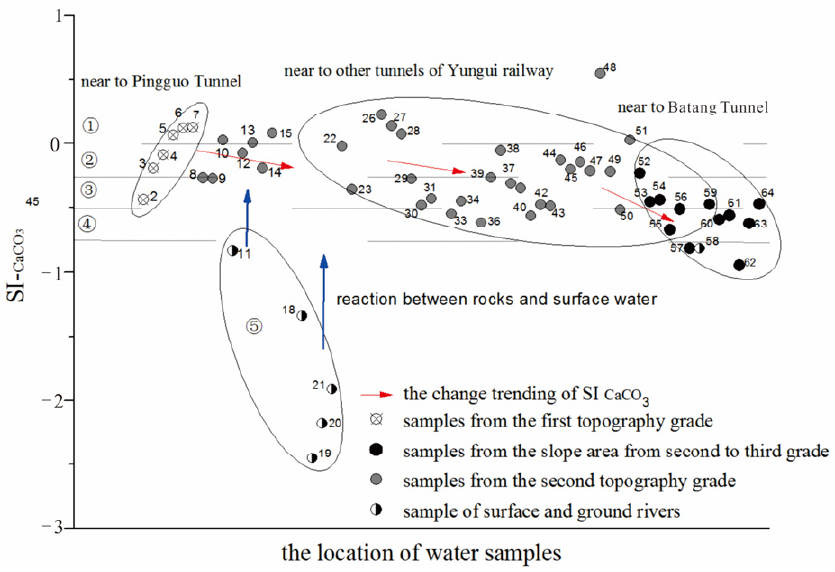
Figure 7. SI- CaCO3 of calcium carbonate in samples. 1 (cid:13) SI ranges from 0 to 0.25; 2 (cid:13) SI ranges from Figure 7. SI- CaCO of calcium carbonate in samples. ① SI ranges from 0 to 0.25; ② SI ranges from 3 − 0.25 to 0; 3 (cid:13) SI ranges from − 0.5 to − 0.25; 4 (cid:13) SI ranges from − 0.5 to − 0.75. − 0.25 to 0; ③ SI ranges from − 0.5 to − 0.25; ④ SI ranges from − 0.5 to − 0.75.